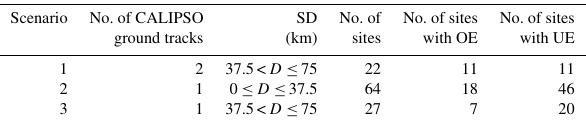
Table 2. Detailed descriptions with regard to the classification cri- teria of the scenario of the positions of the radiosonde site relative to the closest CALIOP profiles, including the number of CALIPSO ground tracks for each scenario, the shortest distance (SD) to ground tracks, the total number of sites for each scenario in China, and the number of sites with overestimated averaged PBLHs (OE) or un- derestimated averaged PBLHs (UE) from CALIOP compared with